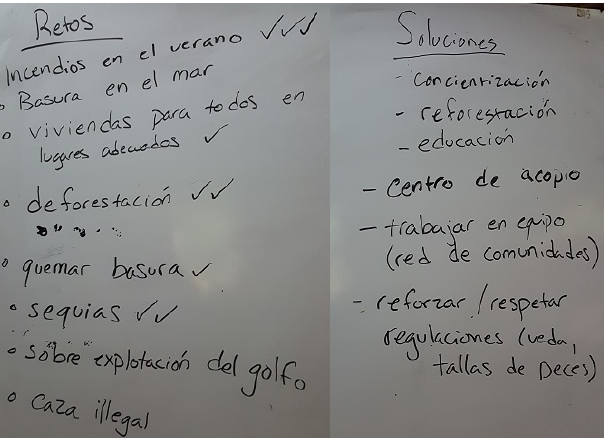
Fig. 9 . Shared environmental challenges ("retos") and potential action steps ("soluciones") in the Costa de Pájaros model-based reasoning